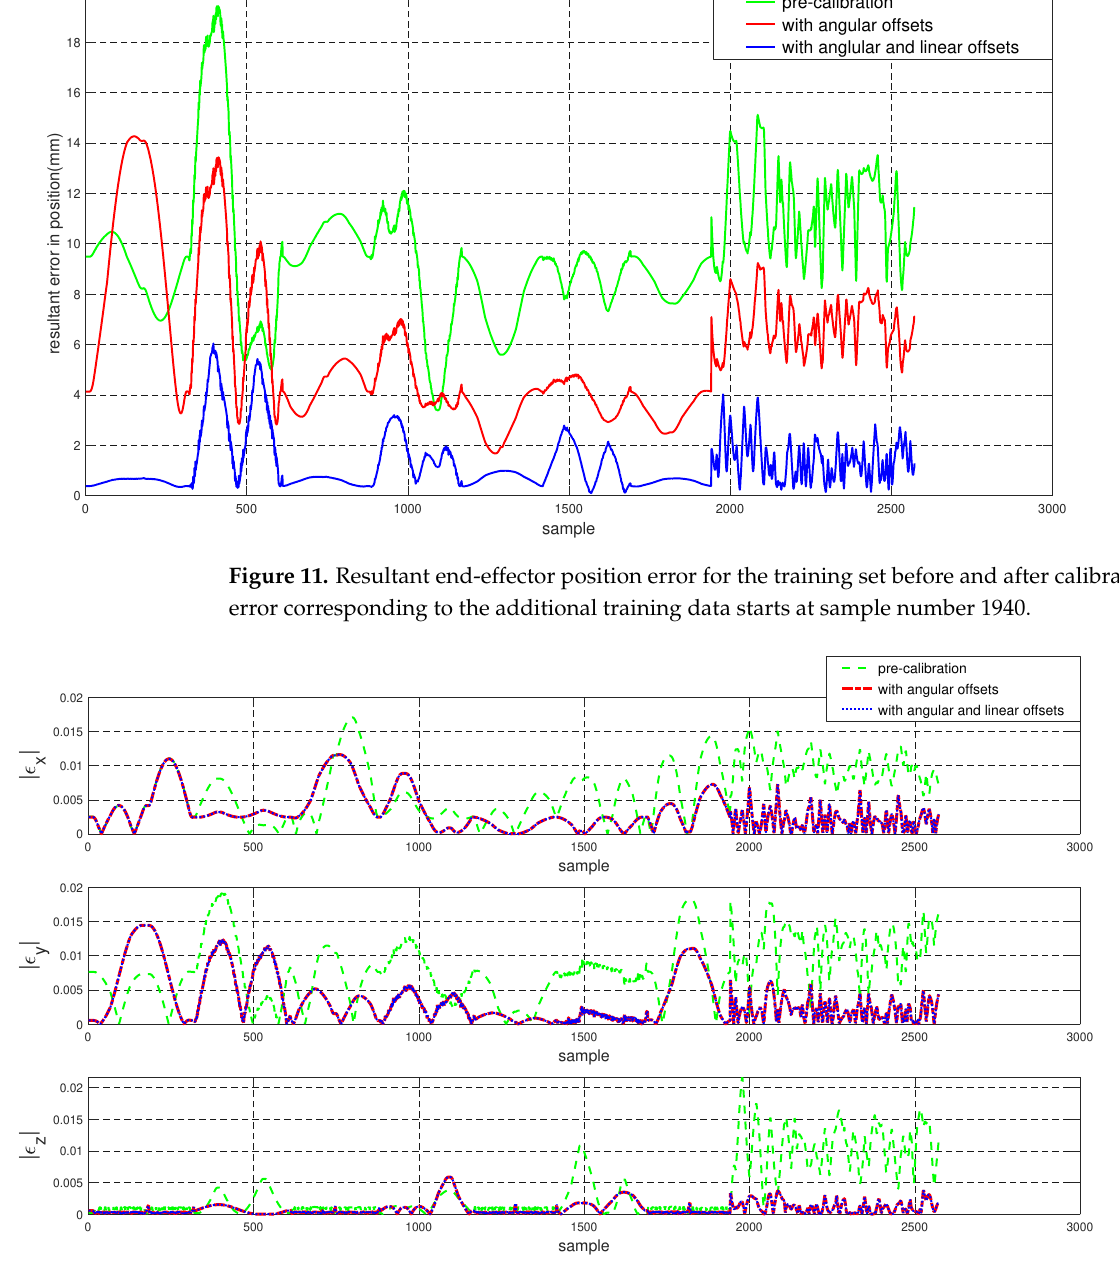
Figure 12. Error in end-effector orientation error ( R T (cid:101) R − I ) ∨ for the training dataset before and after calibration. Table 10. Resultant orientation error before and after